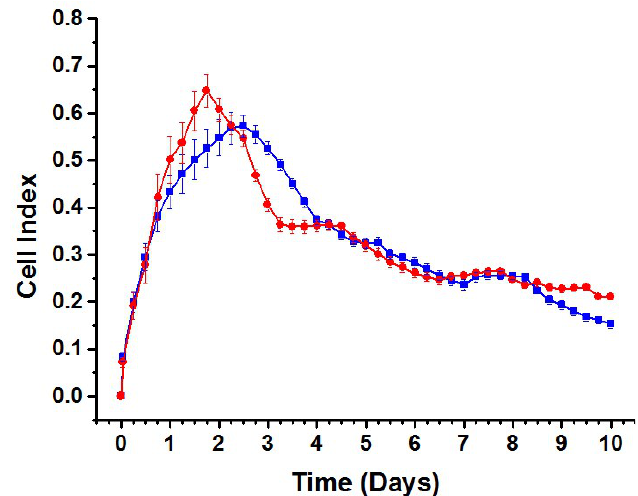
Figure 4. Cell Index vs. time for hVM1 Bcl-X L cells: Initial cell density 120,000 cells/cm 2 . Proliferating (blue) and differentiating (red) cells. Time in days after cell seeding. (Error bars: s.e.m., n = 6).